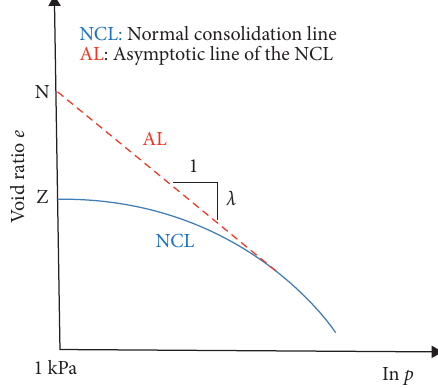
Figure 11: The physical meaning of parameter Z and λ